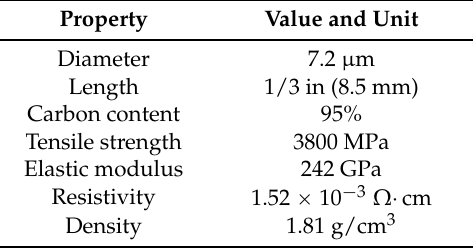
Table 1. Carbon fiber properties.